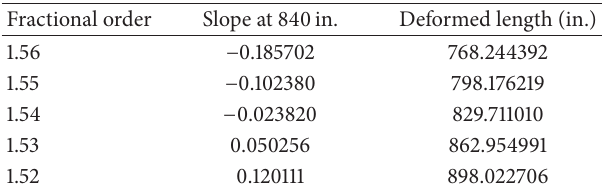
Table 2: Values of slope at 840in. and maximum vertical displace- ment for various fractional orders. Slope at 840 in.